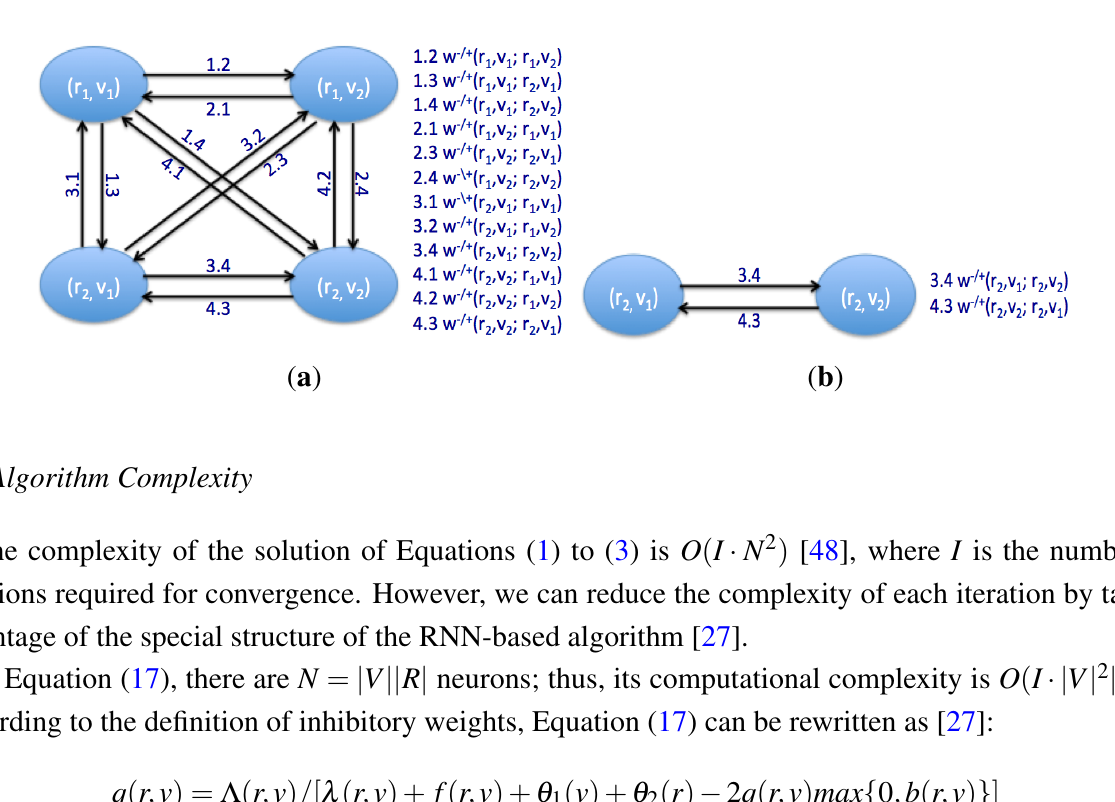
Figure 1. Graph representation of the interactions of a four neuron